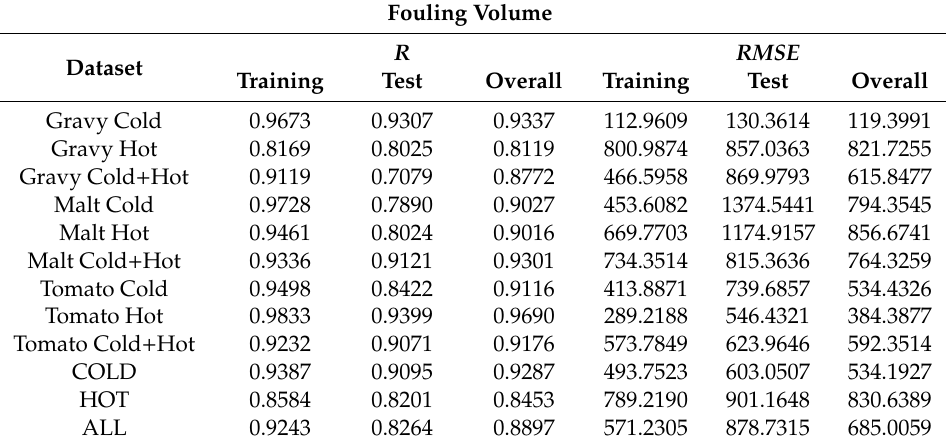
Table 3. Summary of fouling volume NN regression